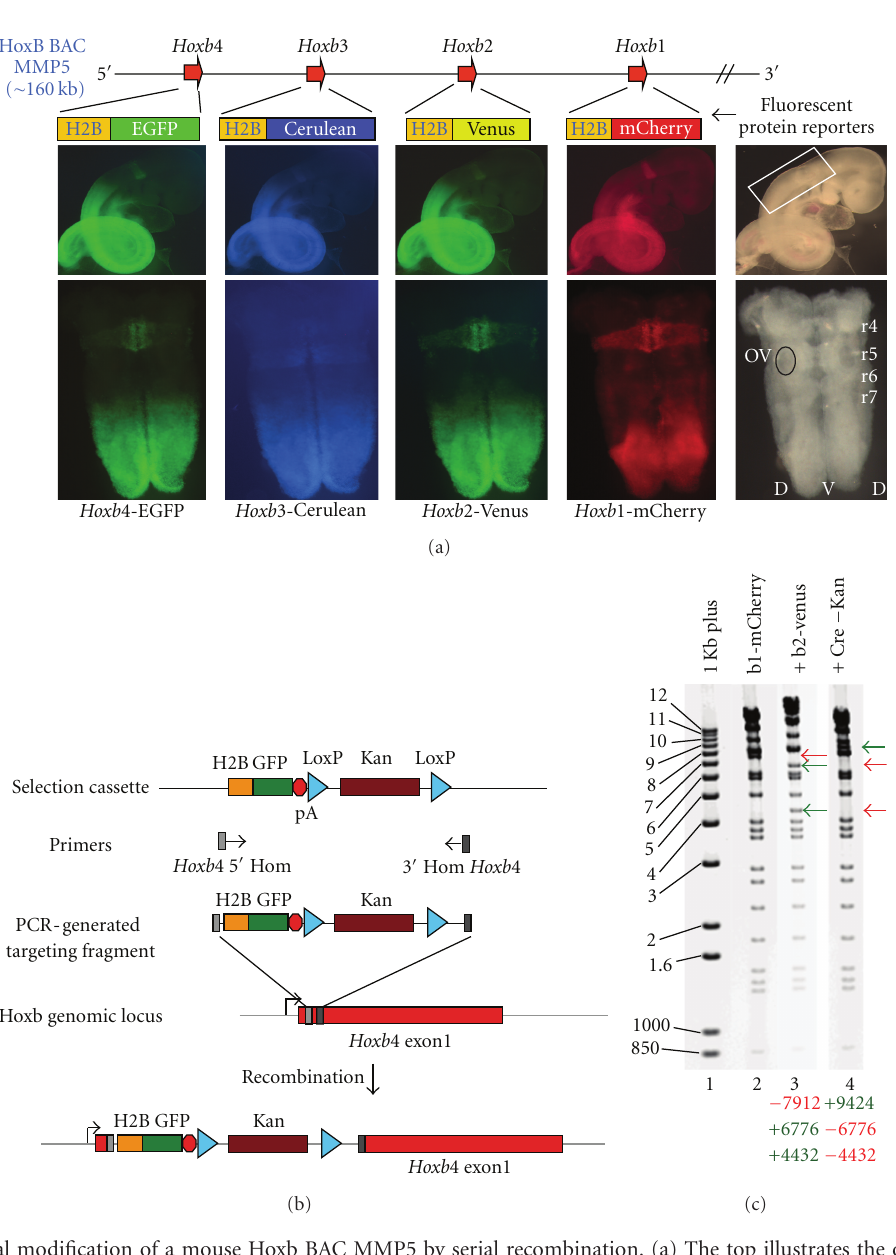
Figure 4: Sequential modification of a mouse Hoxb BAC MMP5 by serial recombination. (a) The top illustrates the organization of the MMP5 BAC containing a HoxB genomic fragment and the respective adjacent Hox genes targeted with four di ff erent fluorochrome reporter insertions through four rounds of serial modification. The middle row shows a single whole 9.5dpc embryo examined under bright field (far right) and fluorescent illumination. This demonstrates that the BAC manipulations generated the four expected fluorescent proteins with appropriate activities in transgenic embryos. At the bottom, flat-mount preparations of the hindbrains dissected from this embryo show activity of the reporters in rhombomeric segments correlates with those expected for the endogenous genes. Hindbrain tissue imaged in the bottom row was taken from the region indicated by the white box in the bright field image in the row above on the far right. r4–7 = rhombomeres 4 to 7 and OV = otic vesicle. (b) It illustrates constructs and strategies for BAC targeting using fragments generated by PCR in combination with di ff erent fluorochrome containing selection cassettes (top). The targeting of the Hoxb4 locus with H2B-EGFP is given as an example. Homology-mediated targeting events are initiated based on primers containing homology to locations indicated in gray and black within the BAC which results in fluorochrome-selection cassette integration at specific locations. (c) At left (lane 1) electrophoresis of 1kb Plus DNA ladder. Lanes 2–4 are NheI digestion of MMP5 BAC variants to monitor targeting events and BAC integrity by banding patterns. One kb Plus band sizes indicated on left. Lane 2 is the BAC MMP5 with an H2B-m Cherry insertion into Hoxb1 . Lane 3 shows the changes in banding pattern when H2B-Venus is inserted into Hoxb2 as evidenced by the loss of a 7.9-kb fragment (red arrow) and the appearance of a 6.7- and 4.4-kb bands (green arrows). After Cre-mediated recombination to remove the selection cassette, a 9.4-kb band is now present and the 6.7- and 4.4-kb bands are now lost as shown in lane 4 as expected from proper targeting. The remaining bands in lanes 2–4 were identical indicating no additional rearrangements. Lost bands are indicated by red arrowheads and newly acquired bands by green arrowheads on the right of each image. ( − ), (+) numbers listed below each digest indicate the sizes of lost ( − ) and gained (+) bands in each BAC